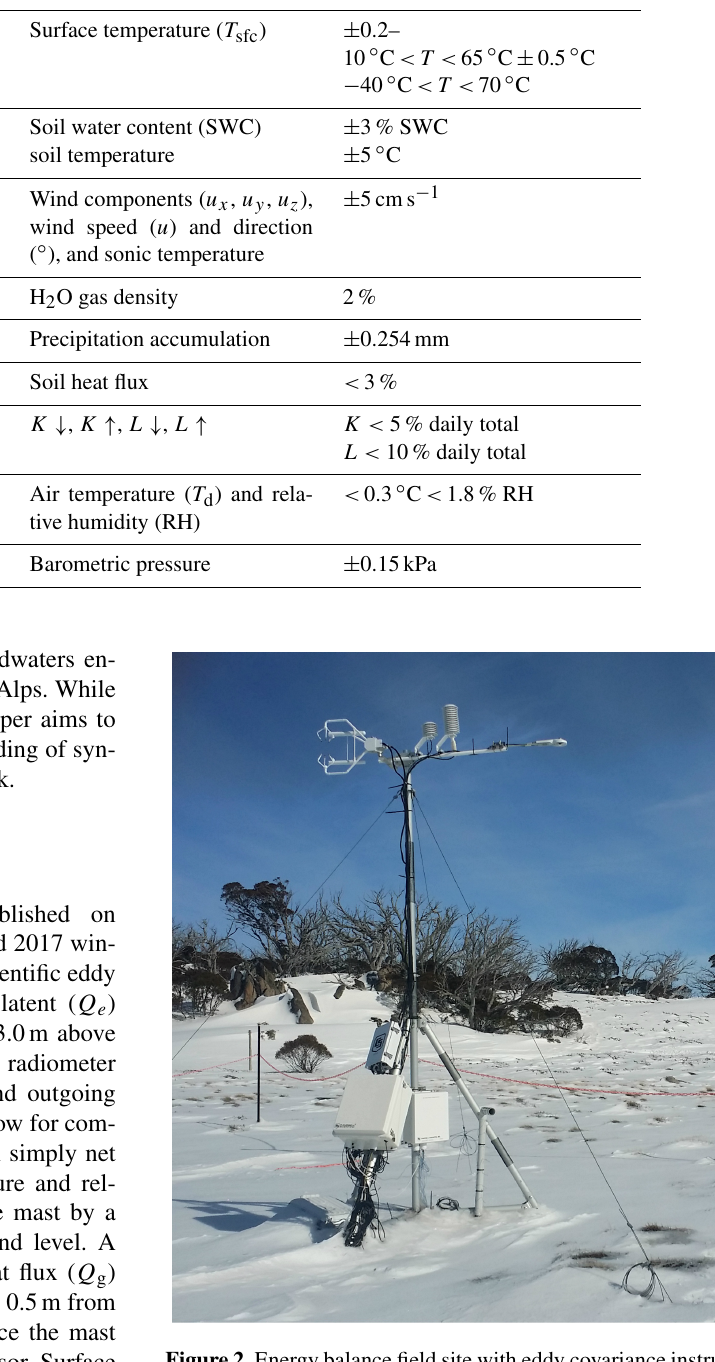
Figure 2. Energy balance field site with eddy covariance instrumen- tation at Pipers Creek catchment